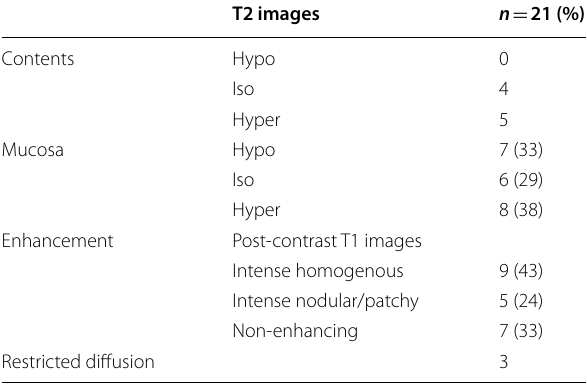
Table 3 MR Imaging findings ( n